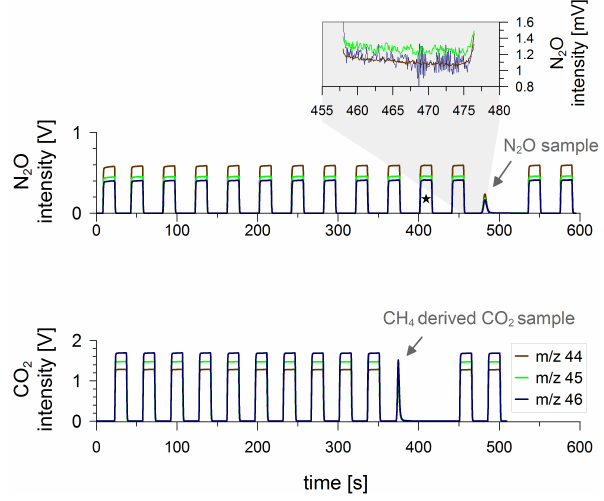
Fig. 3. Chromatograms with the three m/z 44, 45 and 46 traces for CH 4 (bottom panel) and of N 2 O (top panel) measurements. The en- largement in the top panel shows the background before the N 2 O sample peak in detail (units in mV). The flat-topped peaks in the main chromatograms are “on/off” peaks from pure N 2 O and CO 2 reference gases. The chromatograms show the measurement of an ice core sample with low N 2 O and CH 4 mixing ratios, typical for glacial periods. Reference gas peak 11 of the N 2 O measurement (marked with star) includes a very small CO 2 remainder (not visi- ble) stemming from system blank and incomplete CO 2 removal by the Ascarite. We use its isotopic composition to monitor the perfor- mance of the Ascarite trap (Fig.